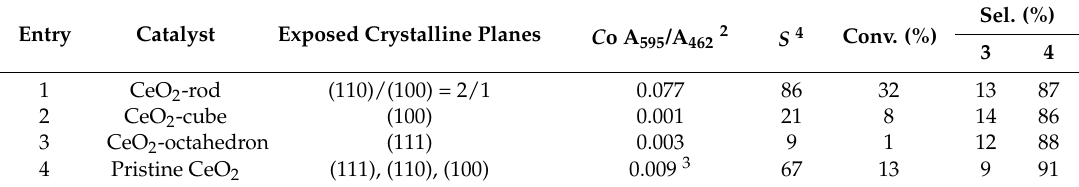
Table 1. Prins condensation-hydrolysis of isobutene with FA in water over CeO 2 with different morphologies 1 .